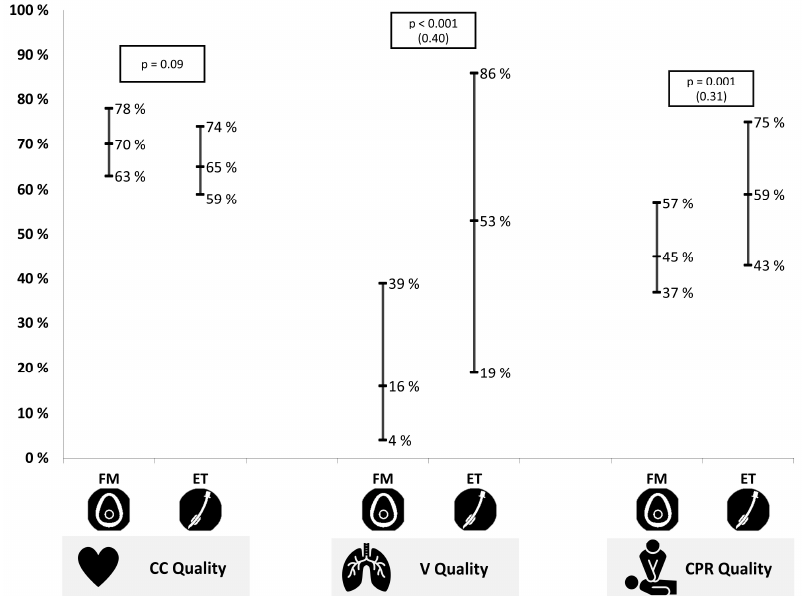
Figure 3. Chest compression, (CC), ventilation (V) and cardiopulmonary resuscitation (CPR) quality for the face mask (FM) and the endotracheal tube (ET) test of the ventilation quality was carried out with adequate volume and pressure. Values were expressed as the median and interquartile range. The effect size is in brackets.